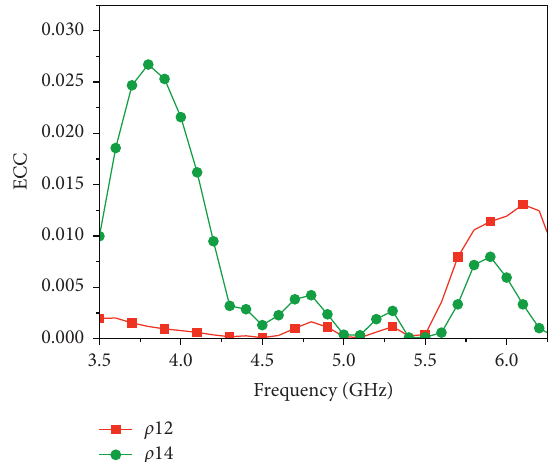
Figure 15: Computed ECC of the proposed MIMO antenna using three-dimensional far fields.